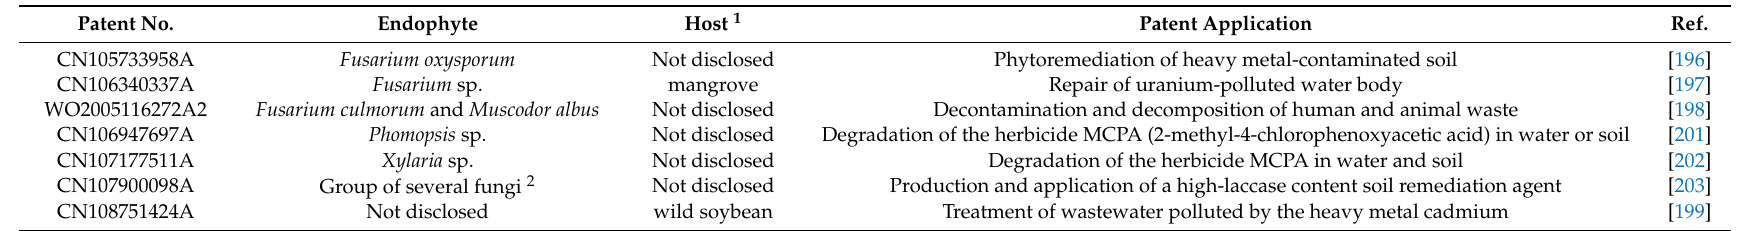
Table 4. Endophytic fungi applied in bioremediation and phytoremediation.